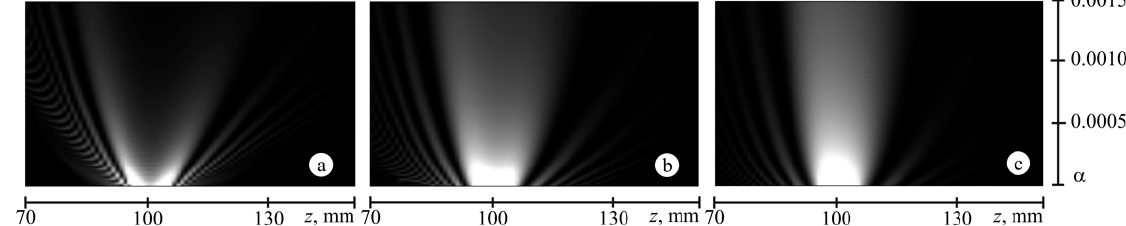
Figure 8. The distribution of the maximum intensity depending on the parameter α ∈ [0.0001; 0.0015] for various values of n : n = 3 ( a ), n = 4 ( b ), and n = 5 ( c ), for λ = 550 nm.